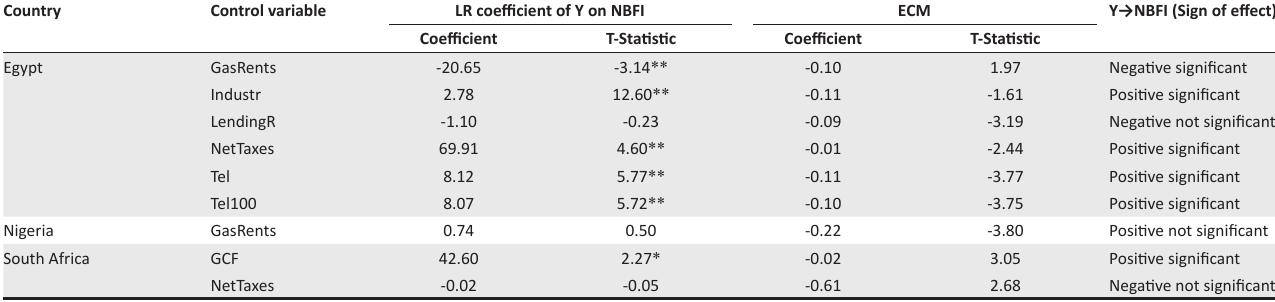
TABLE 5: Long-run parameters of models with causality running from economic growth to non-bank financial institutions. Country Control variable